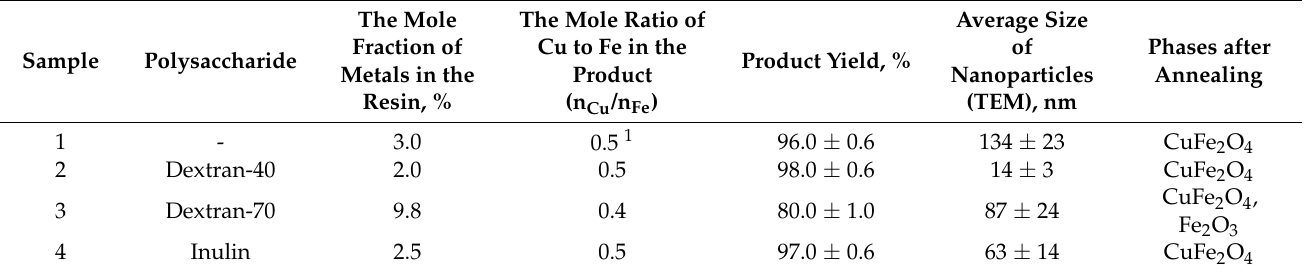
Table 1. Effect of polysaccharides on copper ferrite synthesis and nanoparticle